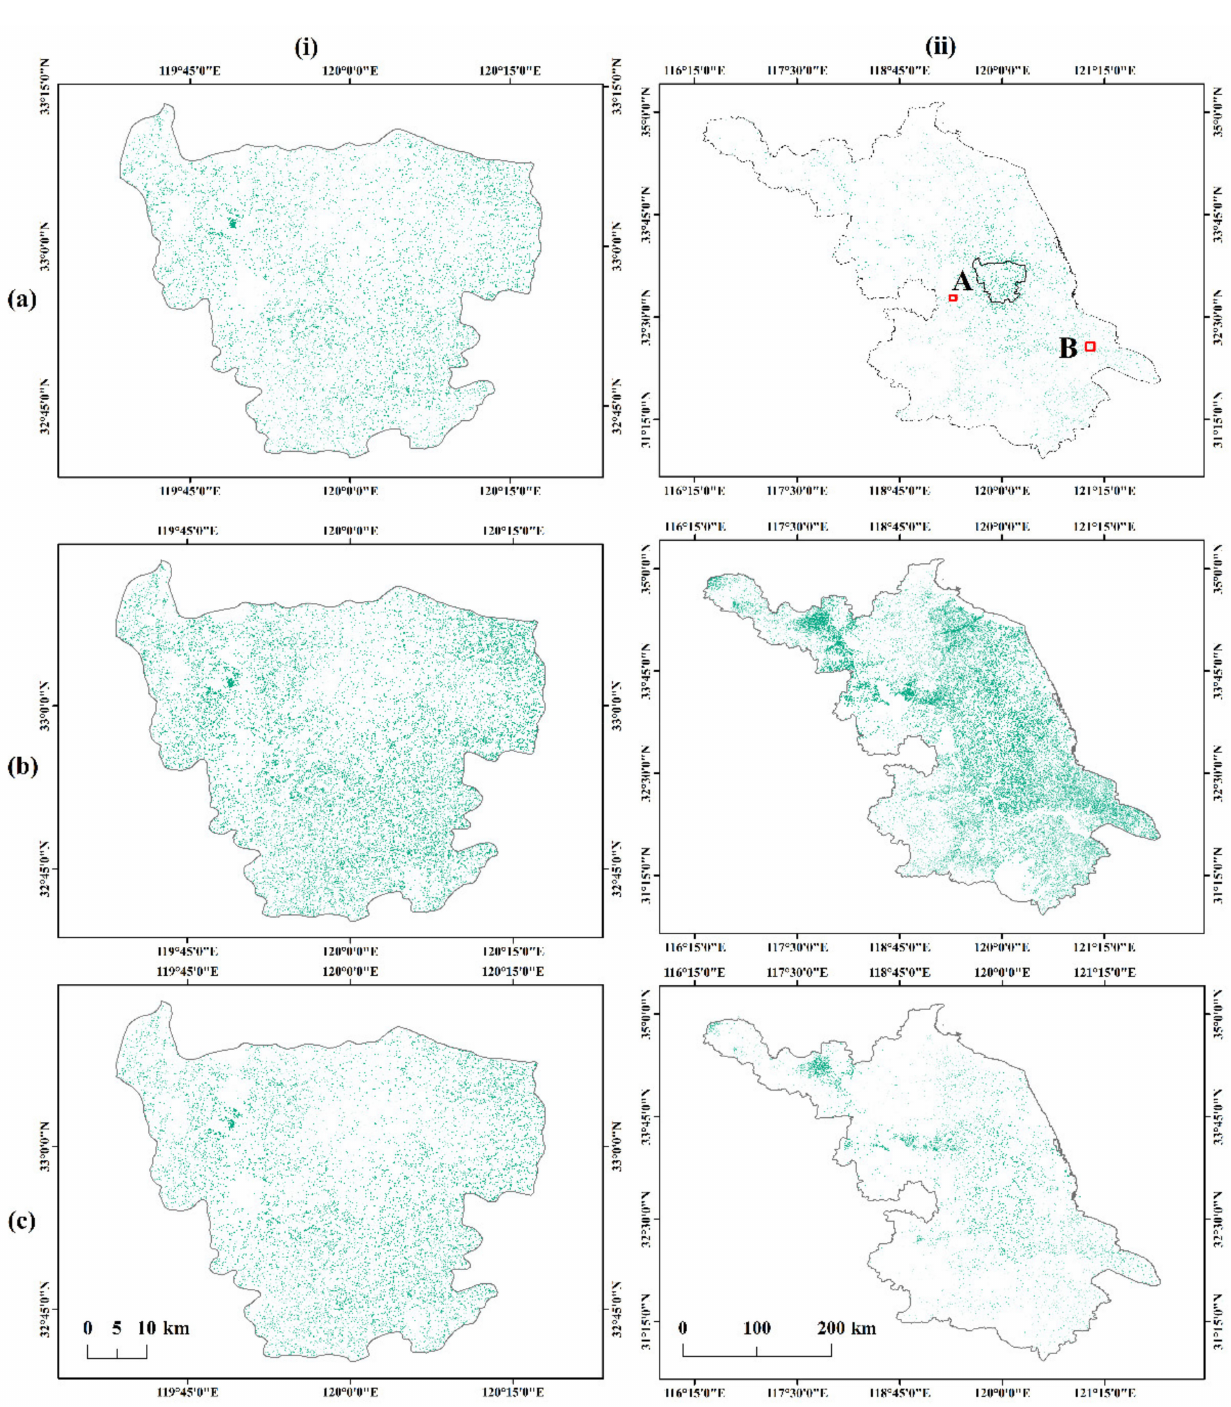
Figure 8. The overall view of rapeseed maps in ( i ) training area, Xinghua County, and ( ii ) testing area, Jiangsu Province, in 2020. Panels ( a – c ) are the rapeseed maps derived from OCED-THAT method, Otsu-THAT method, and RF classification method, respectively. Here, OCED means Otsu with Canny Edge Detection thresholding algorithm, and THAT means two-stepwise hierarchical adaptive thresholding